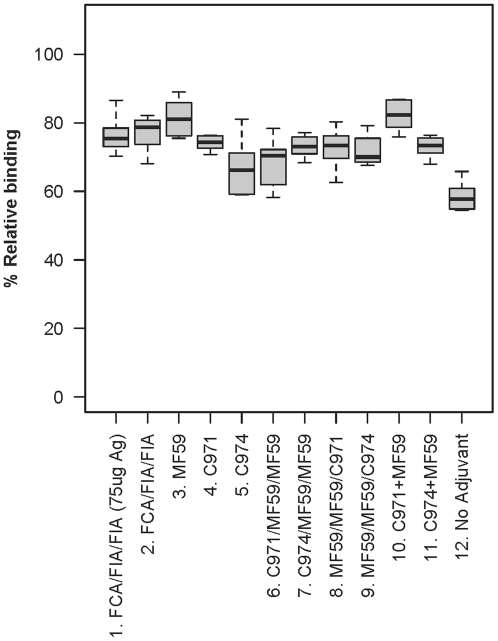
Relative avidity index.Avidity of the antiserum was measured by its ability to remain in binding with gp140SF162 in the presence of 8 M Urea. All samples were found to have relative high avidity, defined as >50% IgG binding in the presence of 8 M Urea, as compared to the no Urea control. Compared to the unadjuvanted group (no. 12), antisera from animals vaccinated with adjuvants have significantly higher RAI (p<0.05).